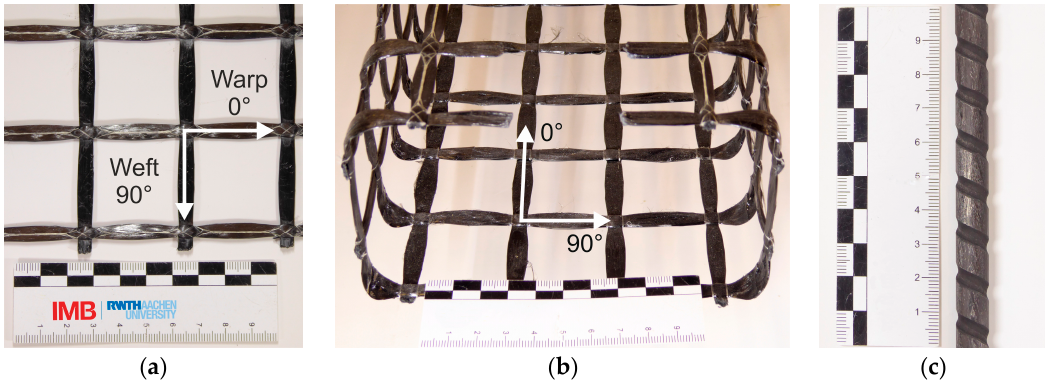
Figure 1. Reinforcement types: ( a ) Planar biaxial carbon fiber reinforced polymer (CFRP) grid; ( b ) pre-formed CFRP grid; ( c ) CFRP rebar with milled ribs.